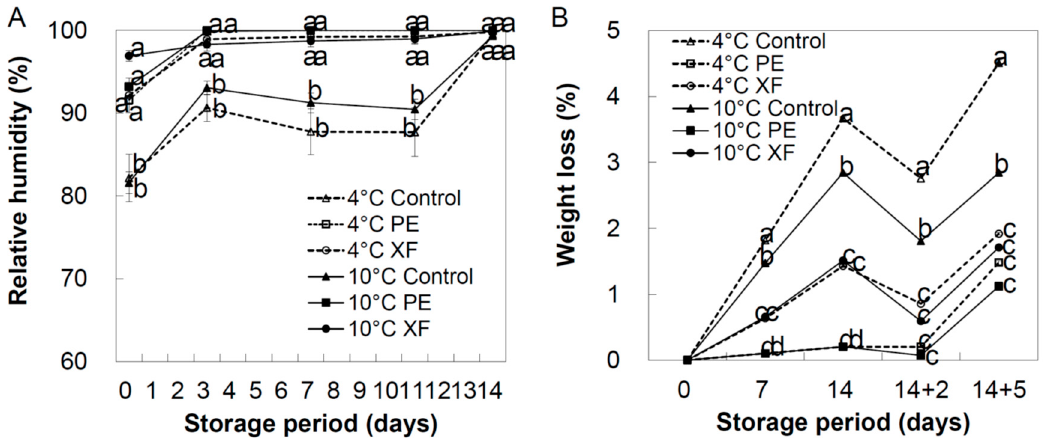
Figure 2. Relative humidity ( A ) and weight loss ( B ) inside the “box-in-bag” packaging of oriental melons. The melons were packaged using 0 polyethylene film (PE), Xtend film (XF), or no film treatment (control), and stored at 4 °C or 10 °C for 14 days. At day 14 + 2 the melons showed relatively lower weight loss compared with day 14, mostly due to the water condensing on the fruit and the box film, underestimating the actual weight loss of the fruit. Data are presented as mean ± SE of three replicates. Different letters indicate significant difference among treatments within the same storage temperature and storage time by Tukey’s HSD test with p < 0.05.